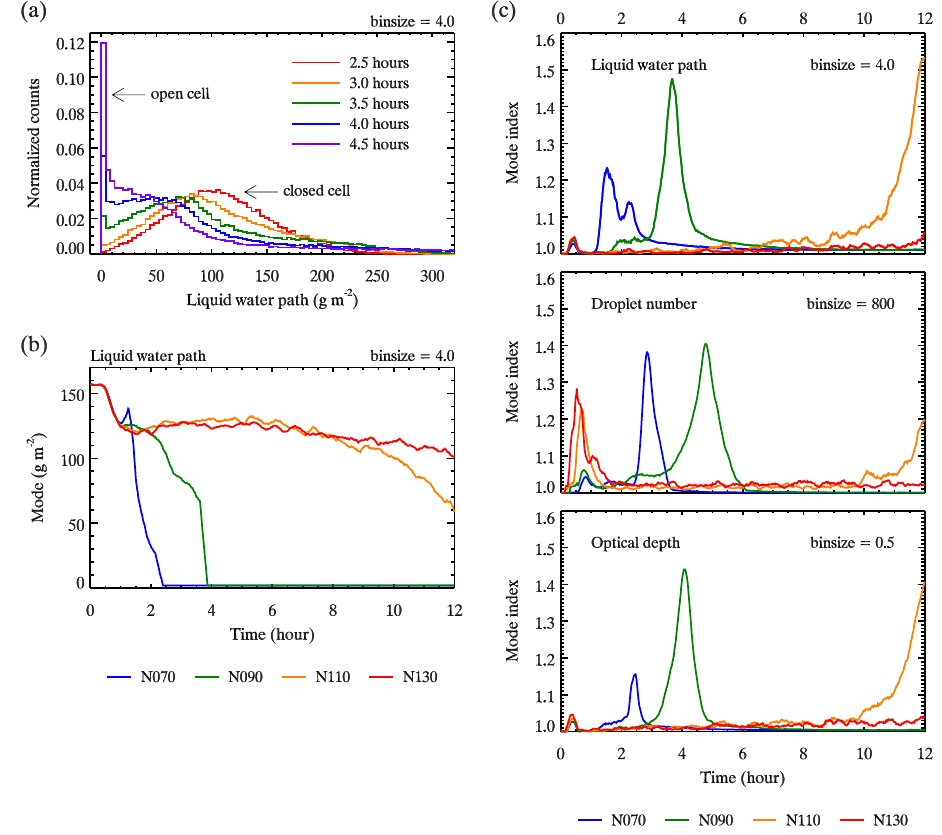
Figure 4. (a) Time evolution of the distribution of LWP for N090, (b) time series of the mode for the distribution of the LWP for selected S1 cases and (c) time series of the mode index based on LWP, N d and τ . A running mean with a 15min window is applied to the mode and mode